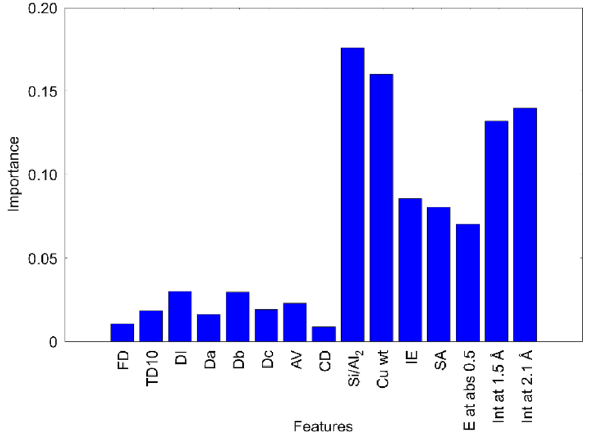
Figure 4. Importance of explanatory variables evaluated by the random forest classification.